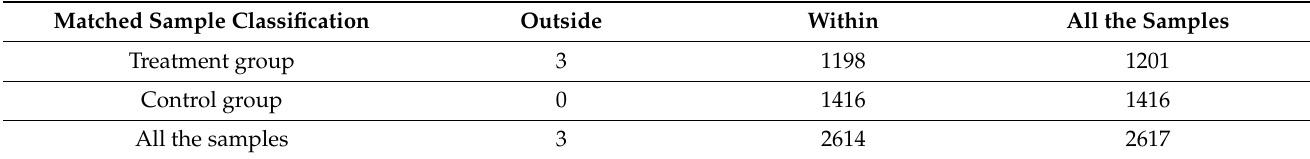
Table 7. The propensity score matches the common value range of